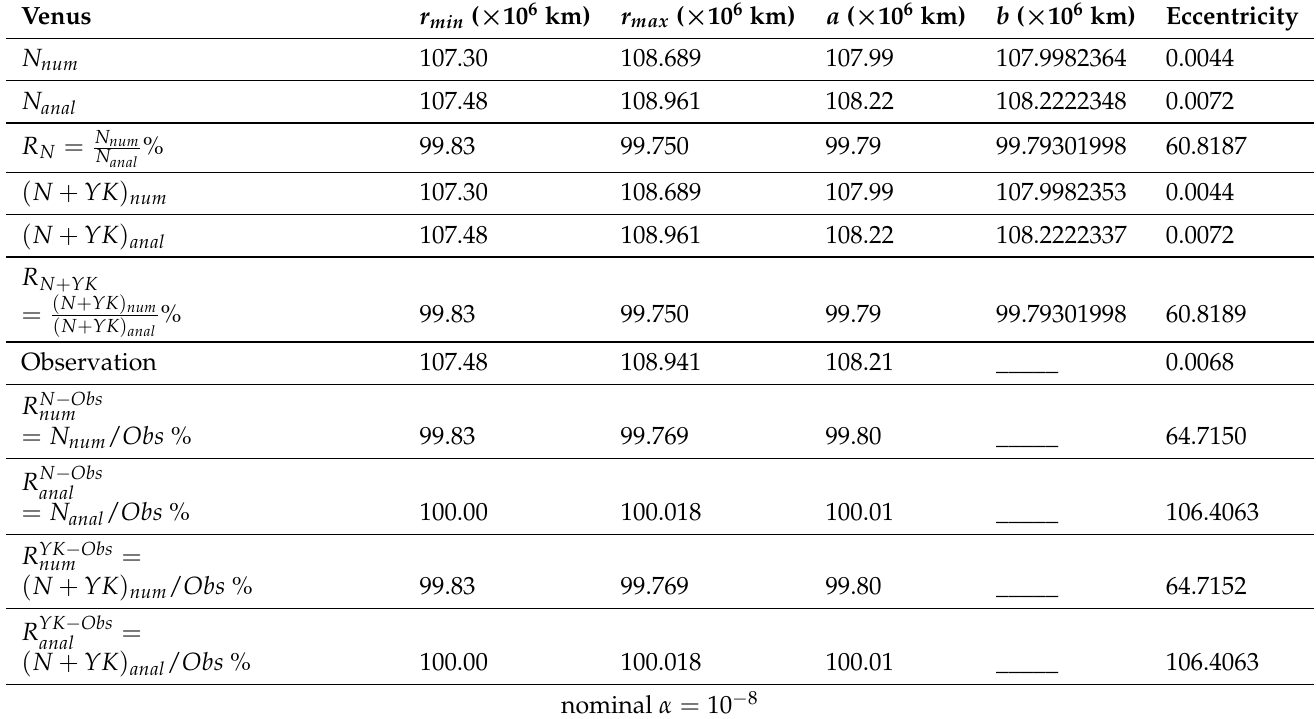
Table A3. The values of the calculated and observational astronomical parameters, for nominal α , of the planet Venus, whose number of moons is